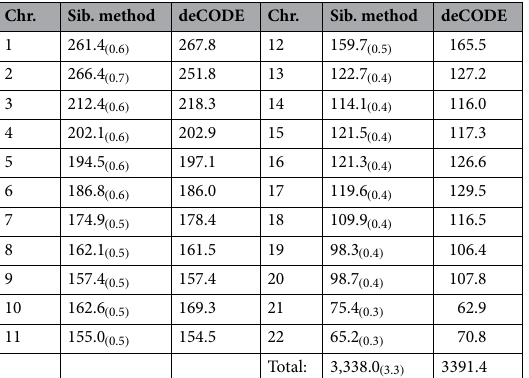
Table 3. Recombination length (centiMorgans) by chromosome obtained from 21,514 UKB European ancestry sibling pairs, compared to deCODE (Iceland) results. Standard error for sibling-pair method given in